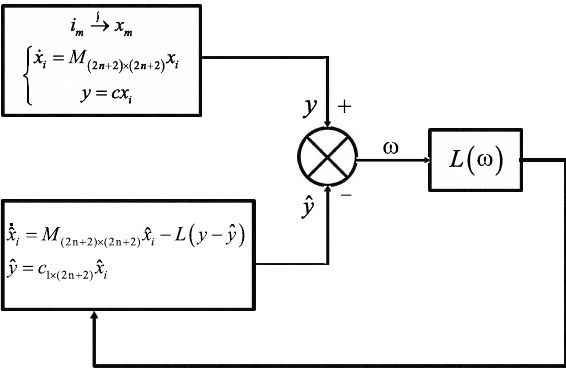
Figure 1. A simple scheme of the input